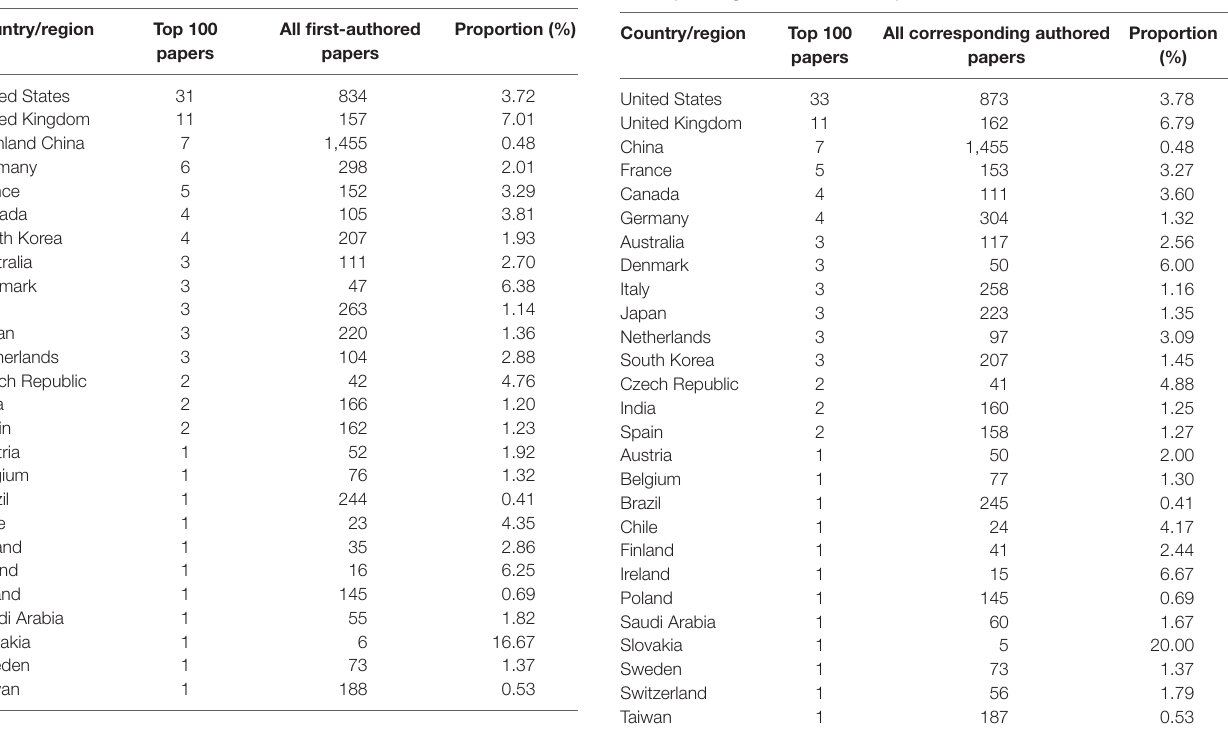
Table 3 | Percentage of top papers by country (based on the location of corresponding author’s